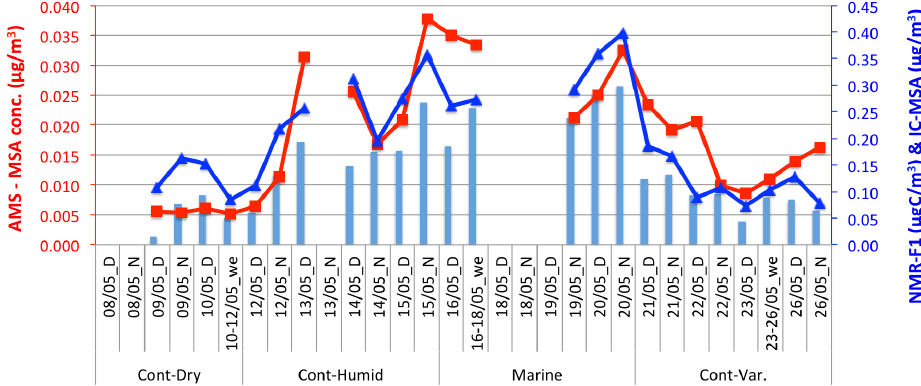
Fig. 6. Comparison between IC measurements for MSA, average NMR MSA-containing factor (referring to right blue axis) and AMS estimation of MSA concentrations from tracer ion CH 3 SO +